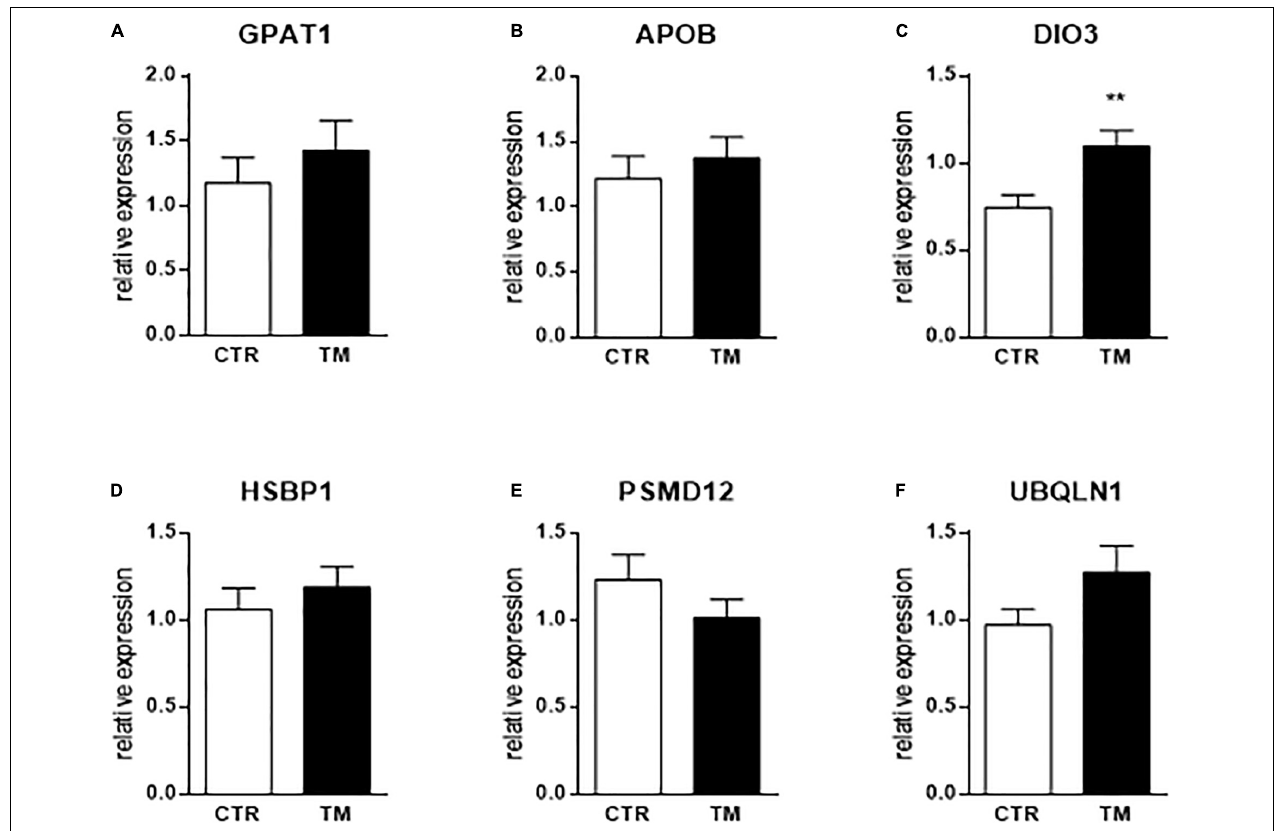
FIGURE 3 | Hepatic relative expression at the end of the heat treatment (E27) of genes influenced by TM before or after overfeeding. Column representation of the relative expression of GPAT1 (A) , APOB (B) , DIO3 (C) , HSBP1 (D) , PSMD12 (E) and UBQLN1 (F) at the end of the thermal manipulation in the liver of control (CTR) or thermal manipulated (TM) duck embryos. Data are presented as mean +/– SEM ( n = 16–19). ** P < 0.01. The absence of a star means that there is no statistical difference between the groups.